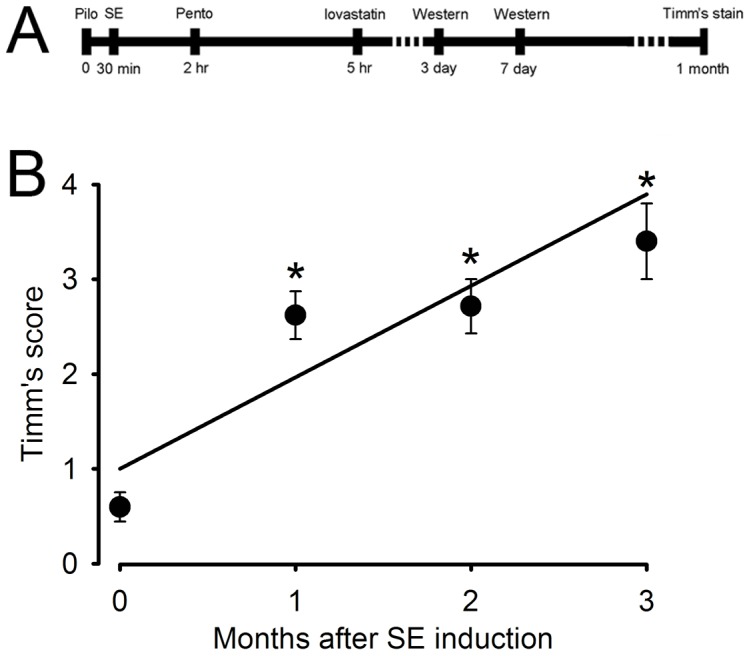
The experimental design and Timm’s score recorded from different time points.(A) The experimental design of TLE animal model and drug administration. (B) Timm’s score recorded from control and 1 to 3 months after SE induction. 1 month after SE induction, the Timm’s score was significantly increased compared with control group and show an increasing tendency with time. (*compared with control group).